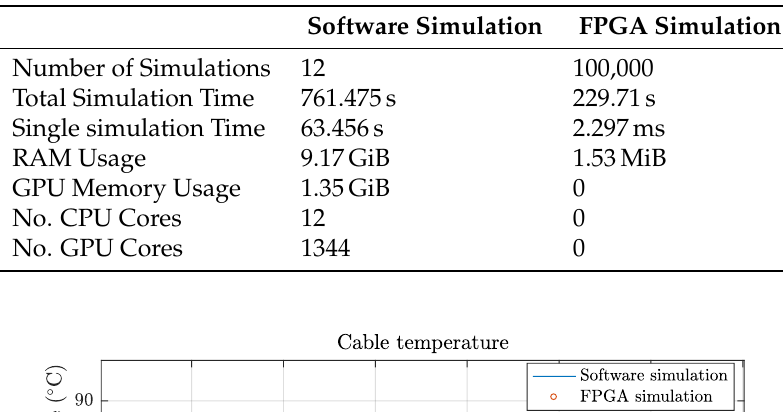
Table 2. Simulation timing and resource use.